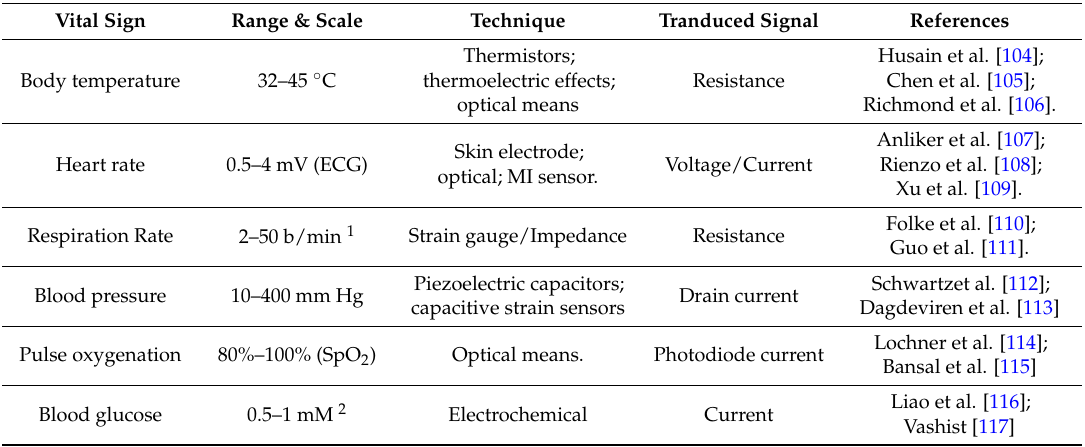
Table 6. Summary of several vital signs and measurement